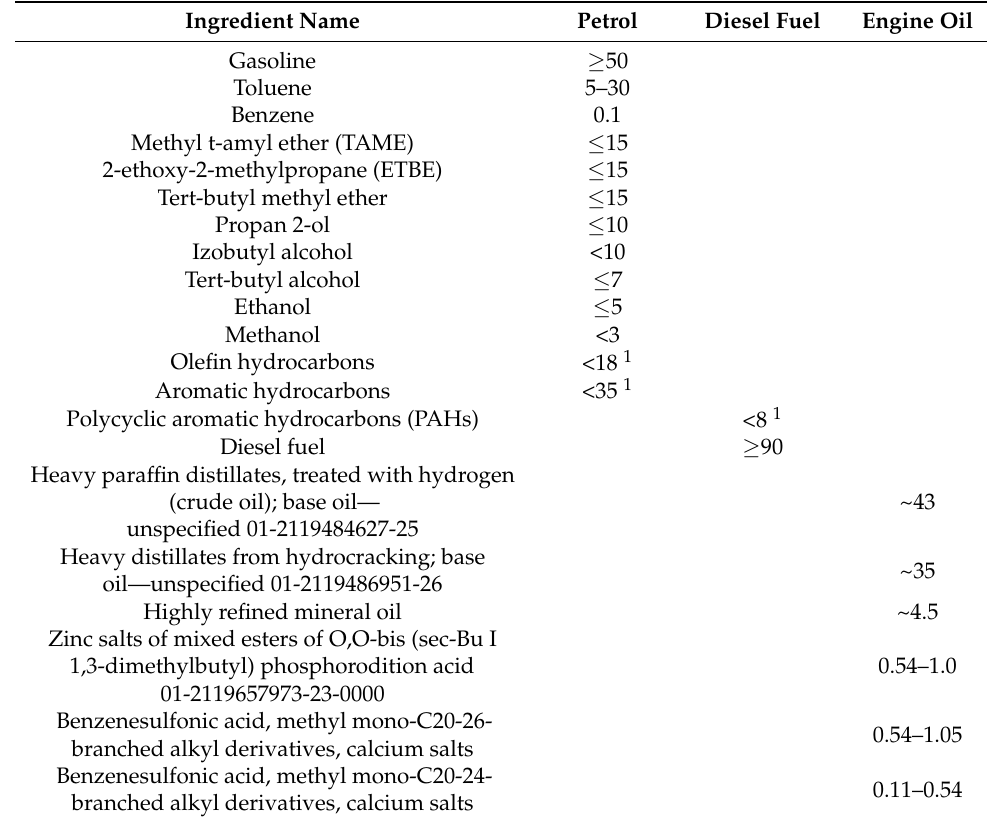
Table 1. Characteristics of the PDSs that were used in the experiment (content in %) according to the material safety data sheets and according to Polish legal